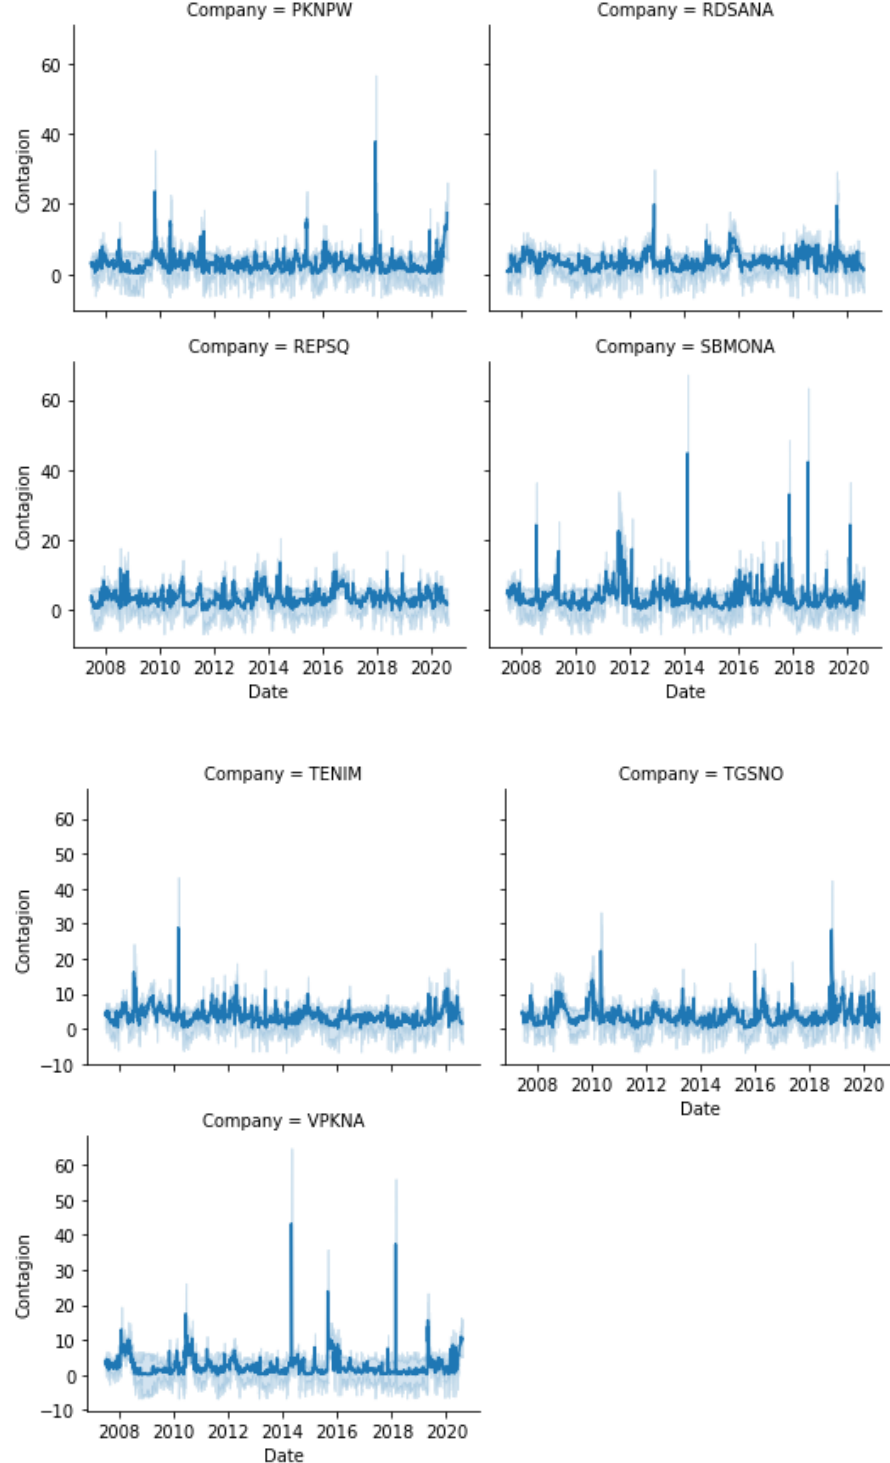
Figure A1. Spillovers (from, to, and net) among companies inside the energy sector for Figure C1. Spillovers (from, to, and net) among companies inside the energy sector for CoVaR CoVaR measures.